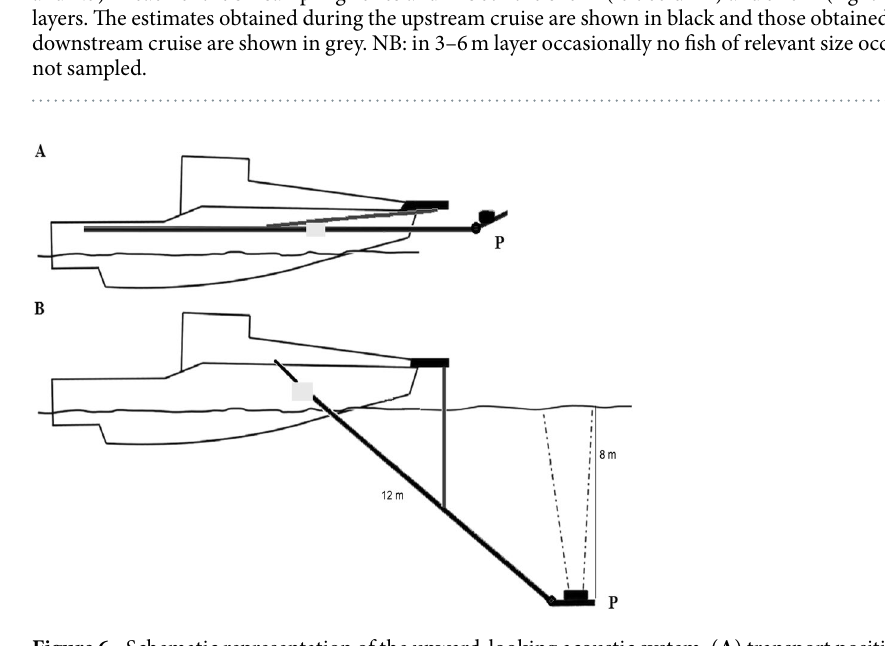
Figure 6. Schematic representation of the upward-looking acoustic system. ( A ) transport position and ( B ) operational position. P - tilltable platform holding the transducers, see details 51